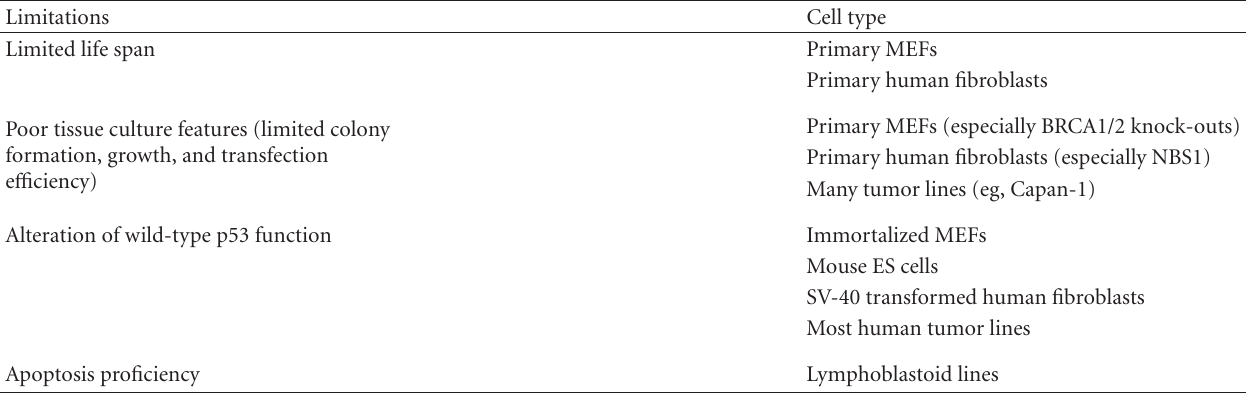
Table 1. Typical limitations to the use of I-SceI based plasmid assays for assessment of chromosomal DSB repair.